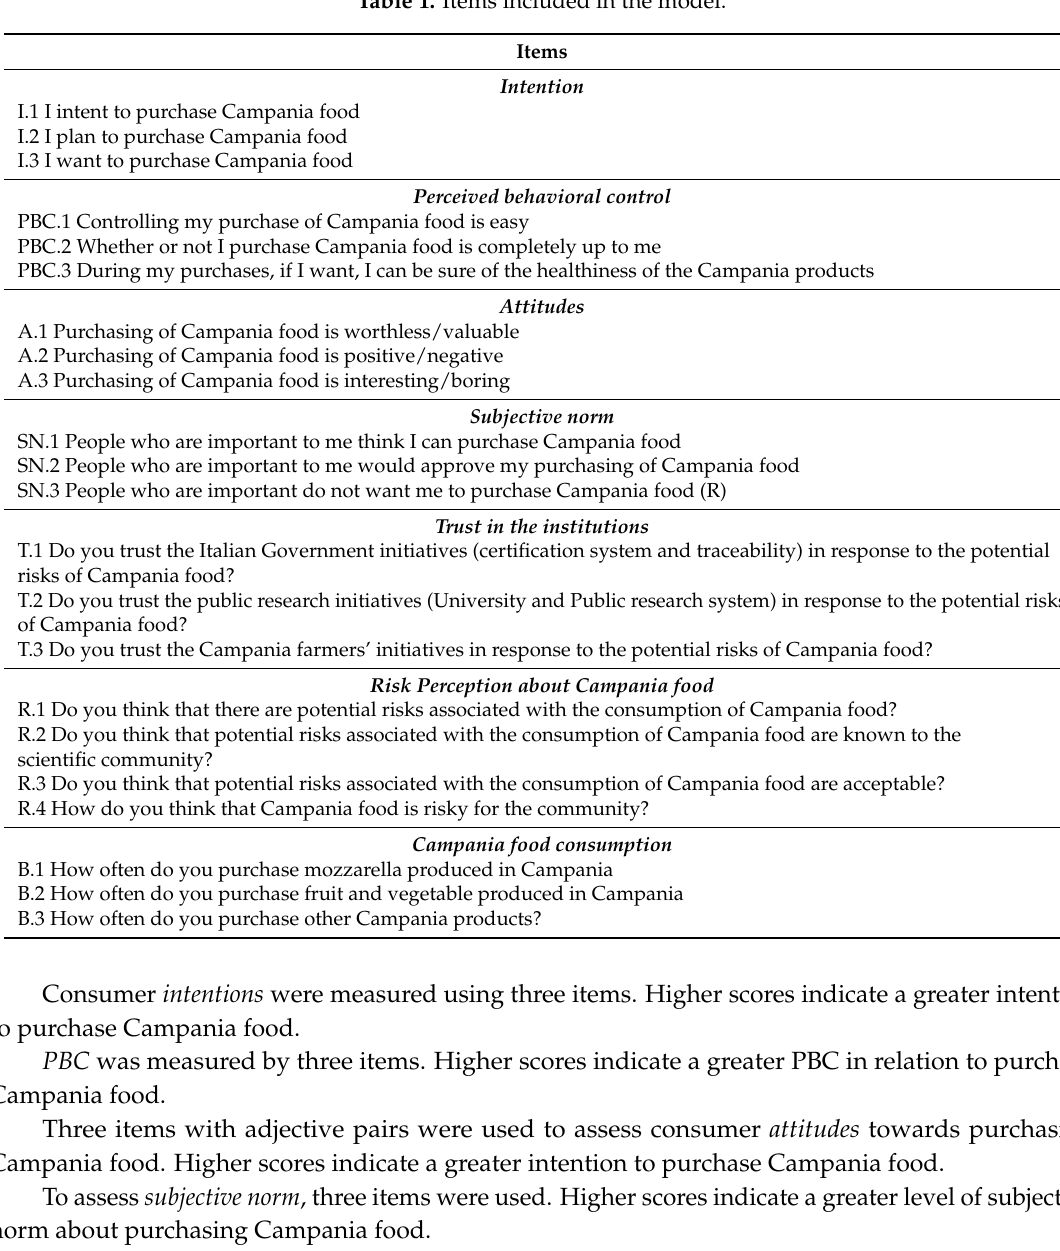
Table 1. Items included in the